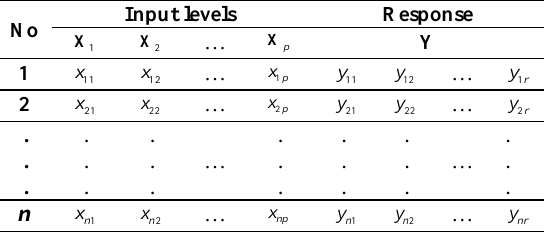
Table 1. Experimental design with RRM.